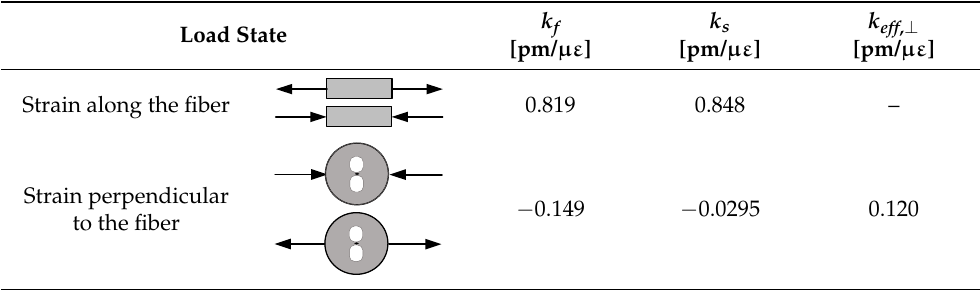
Table 3. Strain sensitivities of the FBG inscribed in SH-2 fiber and integrated in the composite structure.